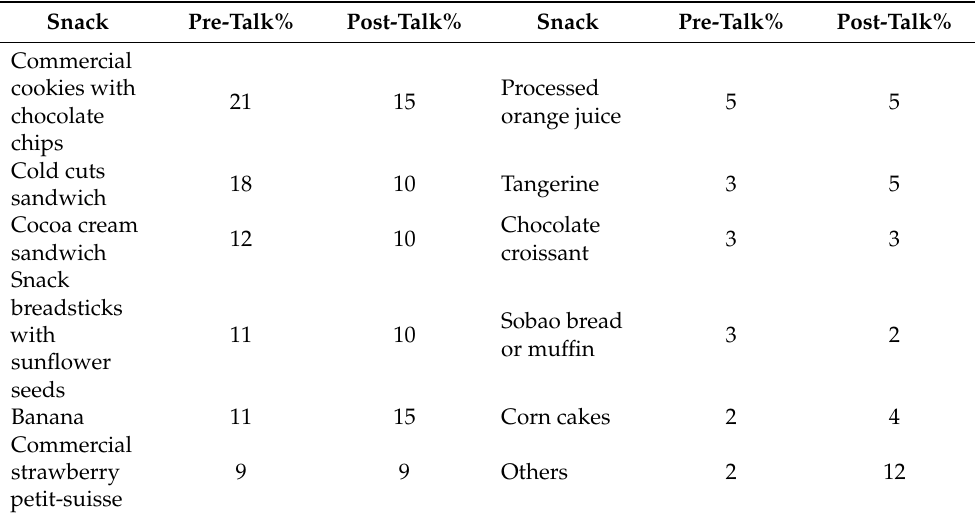
Table 1. Snacks most consumed by experimental group schoolchildren in the first month (pre-talk) and second month